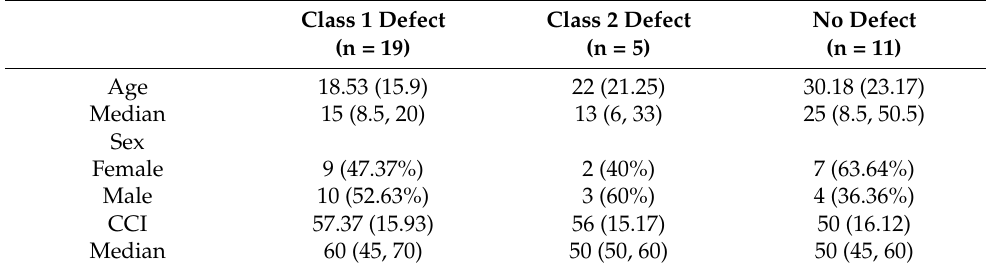
Table 4. Distribution of ultrastructural defects with demographic characteristics, ICC, HSVA and axonemal